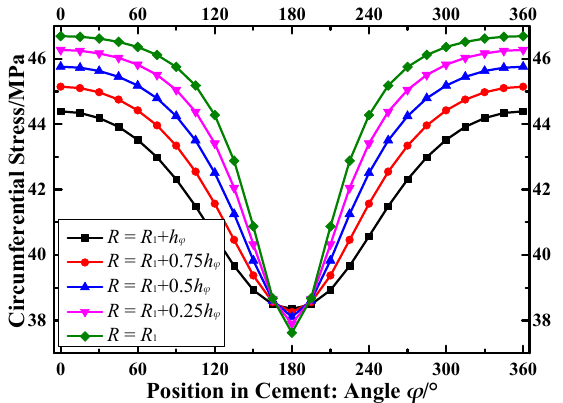
Figure 7. Variation of the circumferential stress with the azimuth angle ϕ at different radii R.